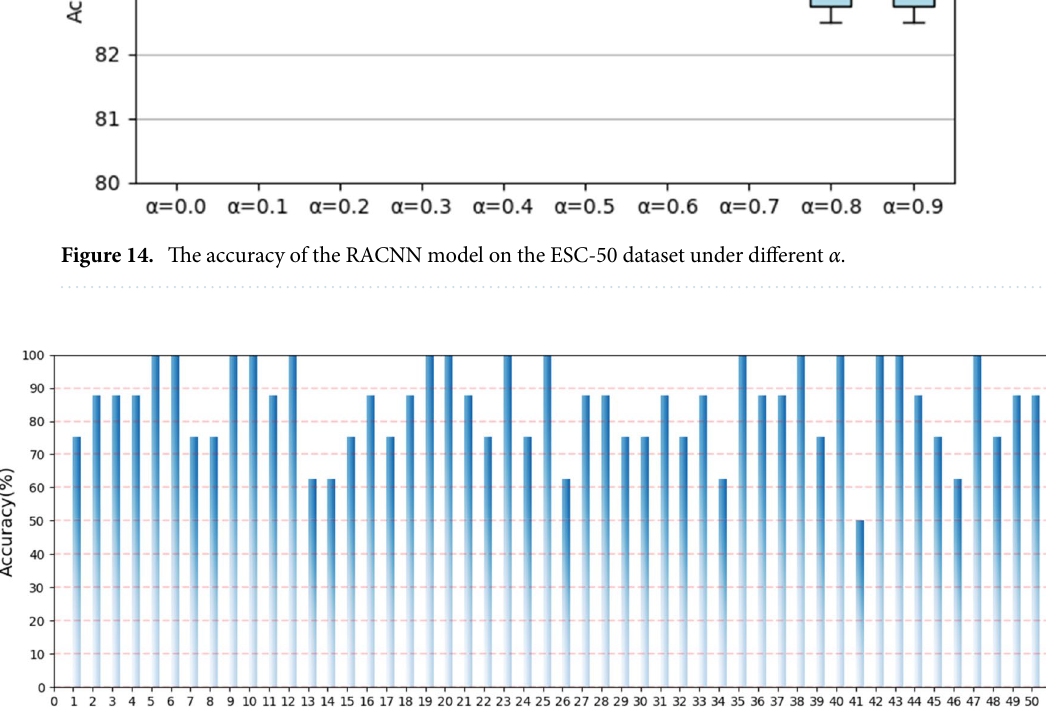
Figure 15. Classification results of RACNN model on the ESC-50 dataset.